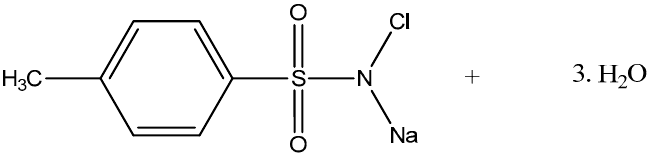
Figure 1. Chemical structure of Chloramine T trihydrate (C 7 H 7 ClNNaO 2 S·3H 2 O).